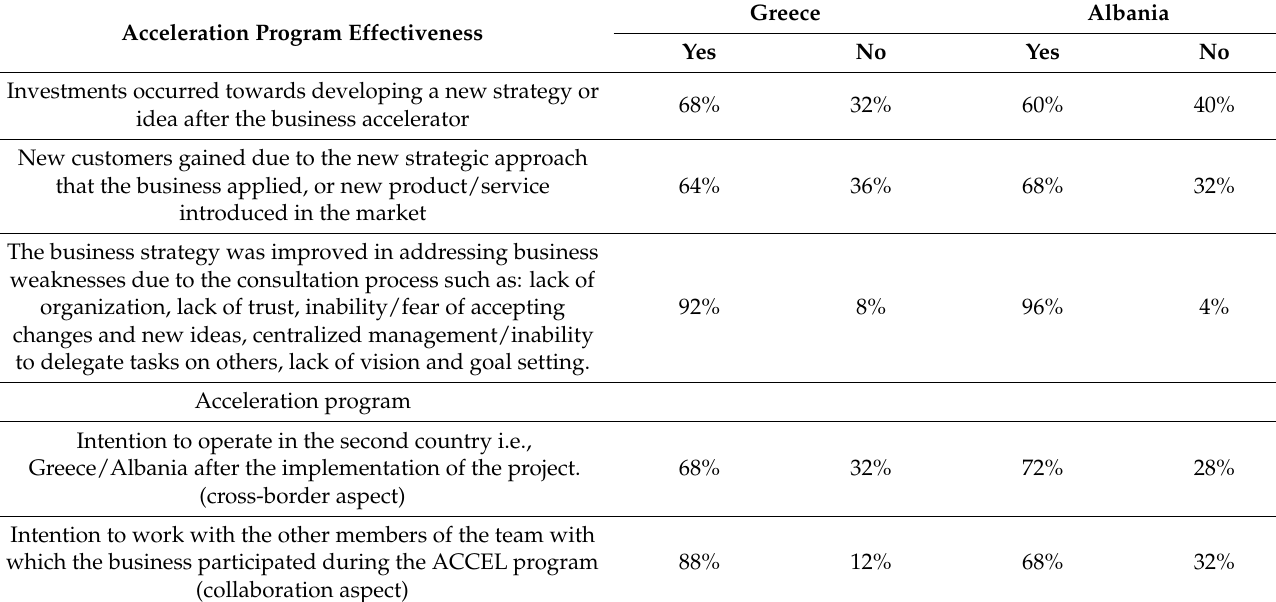
Table 2. Acceleration program